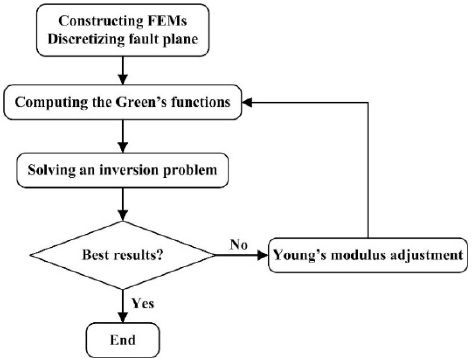
Figure 5. The flow chart of the procedure for solving the inverse problem of the earthquake fault mechanism.